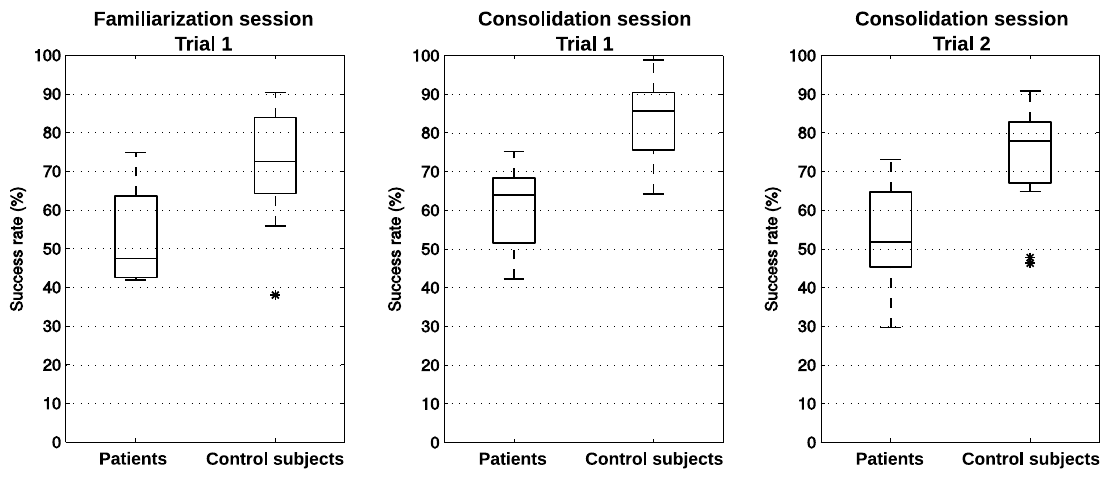
Figure 8. Box plot that summarises the performance between patients and control subjects (CS) with the Myo-Pong tool in each trial. Atypical cases, marked with asterisk, are